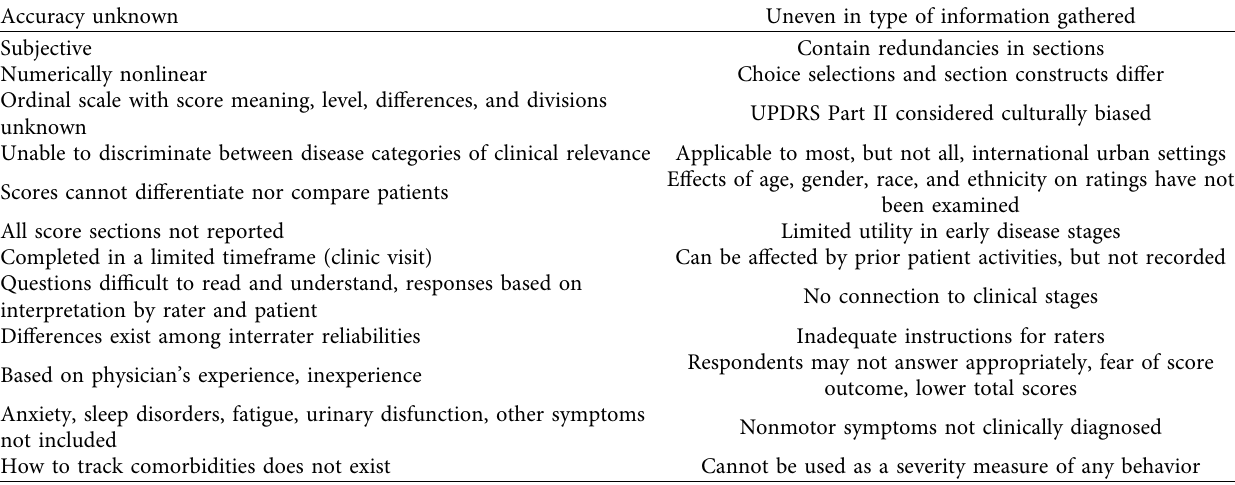
Table 1: A summary of the UPDRS limitations